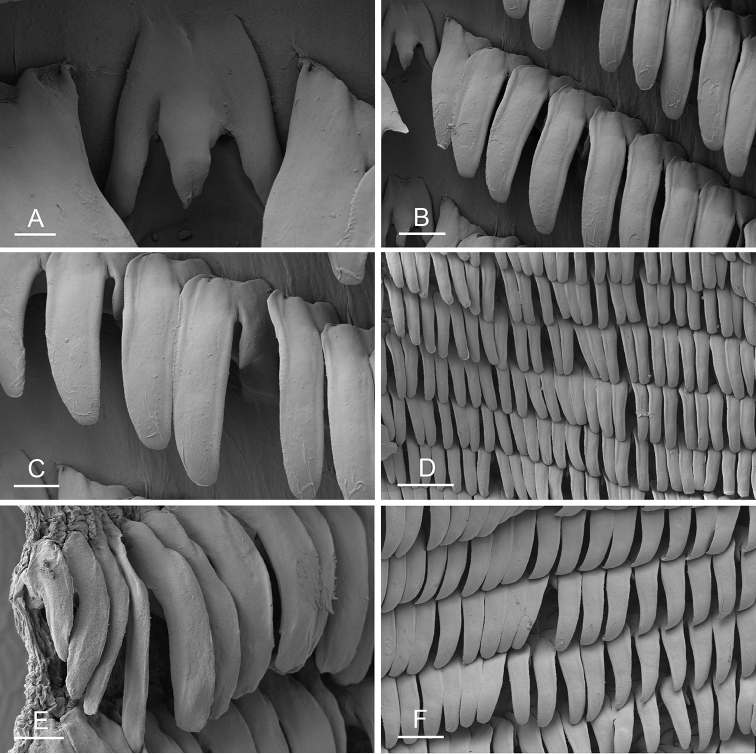
Radula, Peronia
verruculata, Red Sea, spm #3 (ZMH 27472/4) A rachidian tooth B rachidian and innermost lateral teeth C lateral teeth D lateral teeth E outermost lateral teeth F lateral teeth. Scale bars: 10 μm (A), 30 μm (B), 20 μm (C, E), 100 μm (D), 60 μm (F).